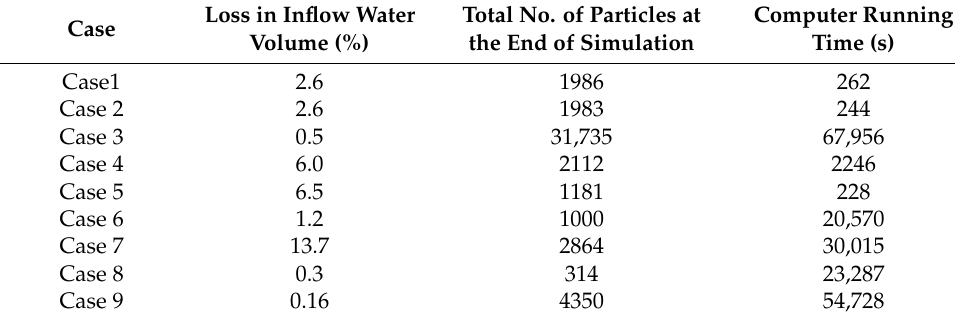
Table 6. Summary of results for the nine flooding cases.